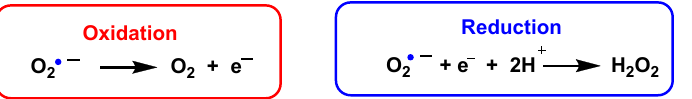
Figure 4. Oxidation and reduction of O 2• − to form oxygen or hydrogen peroxide, respectively.